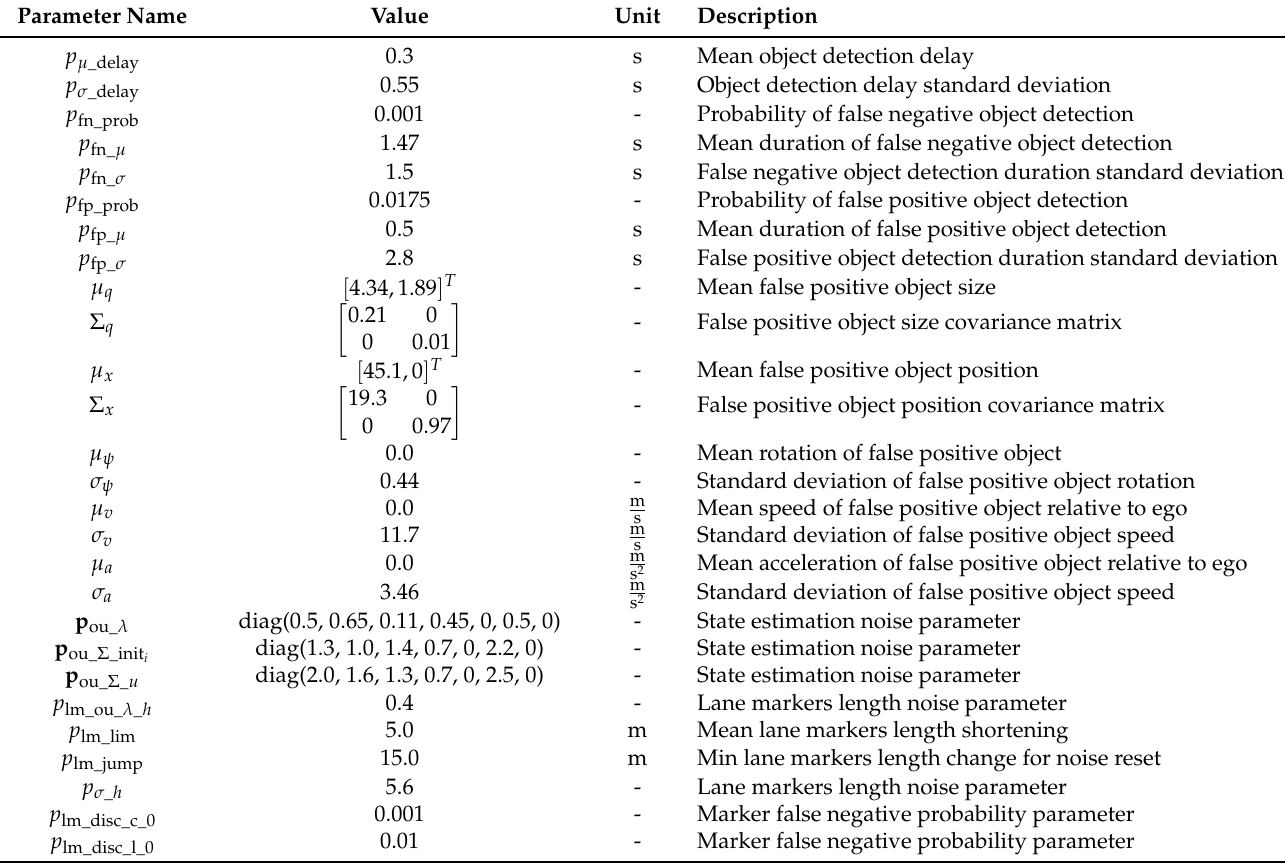
Table A1. Values of sensor models calibration parameters used in the experimental